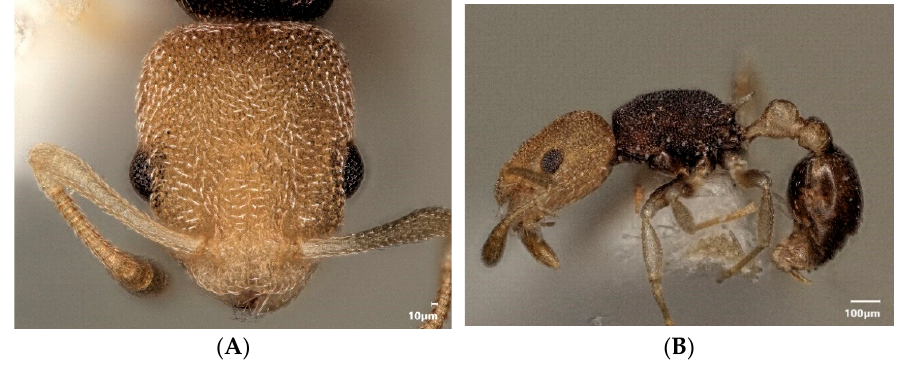
Figure 10. Cardiocondyla argentea n.sp. paratype: head in dorsal view ( A ), lateral view ( B ), dorsal view ( C ), vertex median of the eye ( D ).